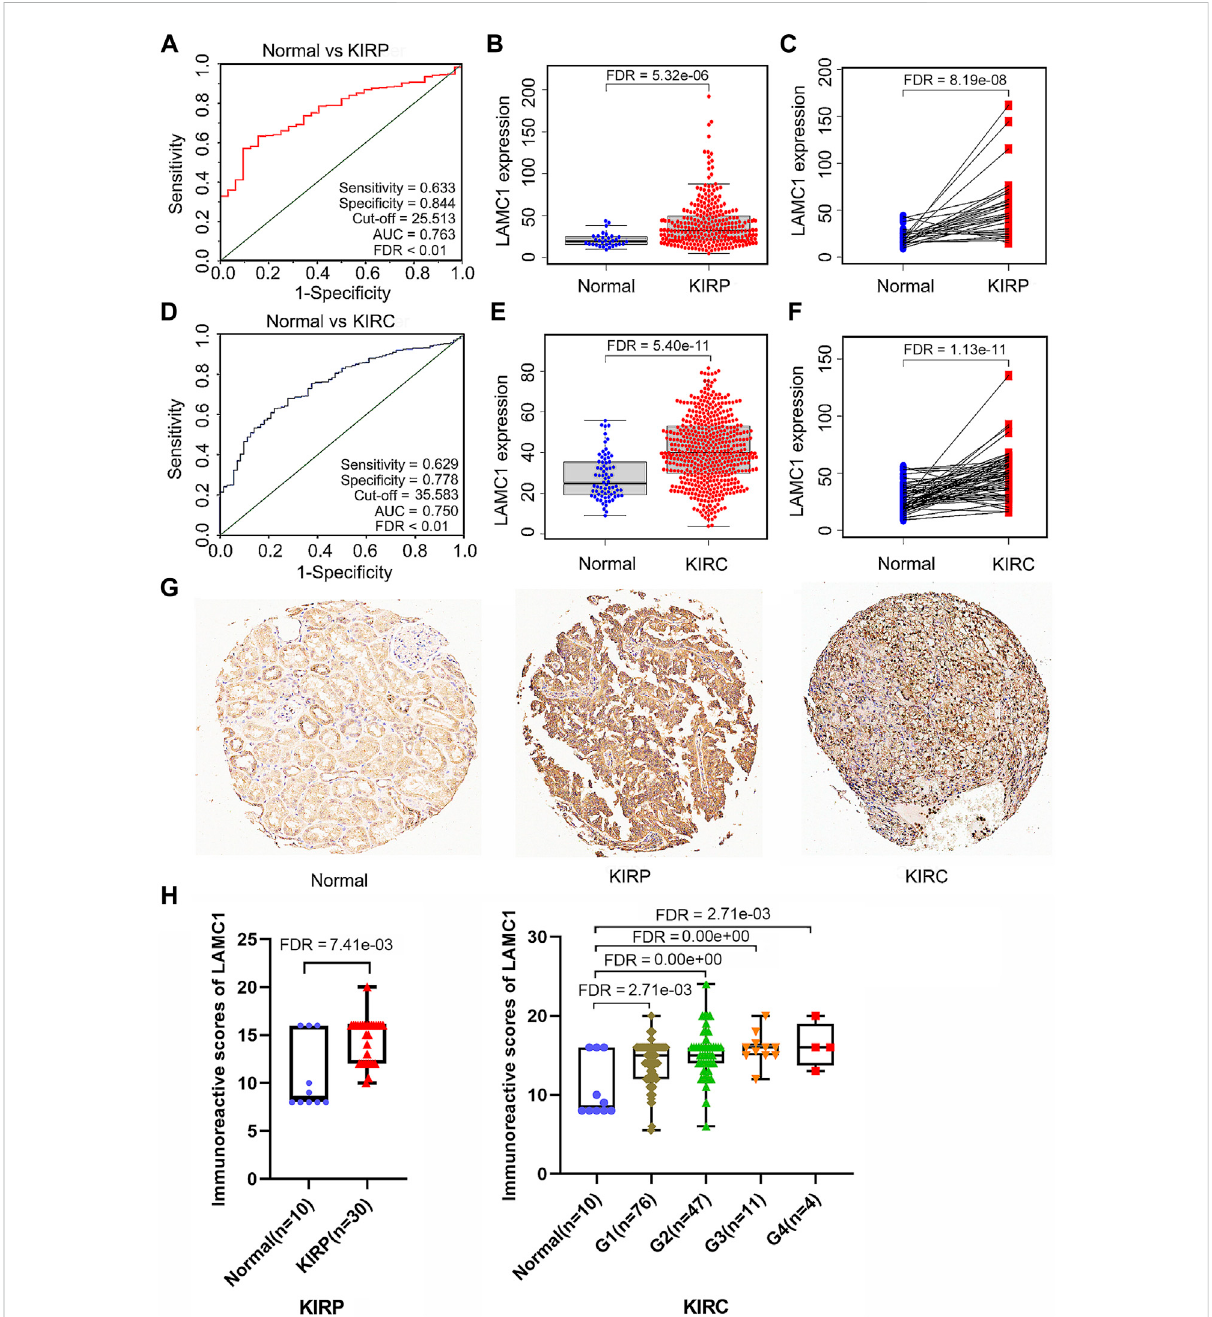
FIGURE 2 LAMC1 mRNA and protein expression levels intwo types of renal carcinoma. (A,D) The receiver operating characteristic (ROC) curvefor LAMC1 expression in normal kidney tissue and kidney cancer was built based on data downloaded from TCGA database. (B – C,E – F) The mRNA level of LAMC1 inkidneycancerandnormaltissues. (B – C) ,KIRP. (B) :N:T=32:289; (C) N:T=31:31, (E – F) ,KIRC; (E) N:T=72:532, (F) N:T=72:72;The fi gure represents the number of the normal(N) or tumor(T) cases; B and E , unpaired t -test; C and F , paired t -test. (G) Three representative images of tissue microarray results are used here. Positiveimmunostaining was located inthe nucleus or cytoplasm. Validation ofprotein expression of LAMC1 in kidney cancer and normal tissues based on tissue microarray staining data. (H) The immunoreactive score of LAMC1 IHC staining presented by boxplot with Student ’ s t test or one-way analysis of variance